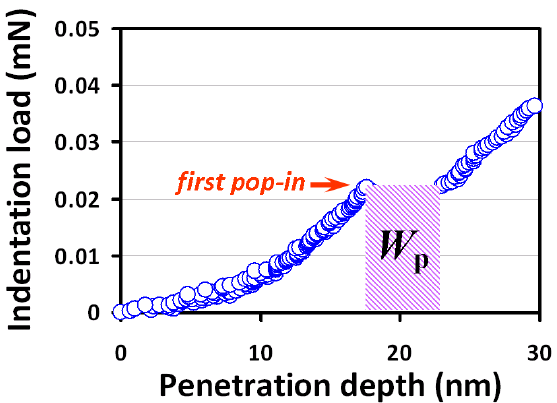
Figure 5. The corresponding first pop-in event from Figure 3a is zoomed in to depict the plastic strain work, W p , which is approximated as the product of critical loading and the sudden incremental displacement indicated by the shaded area.